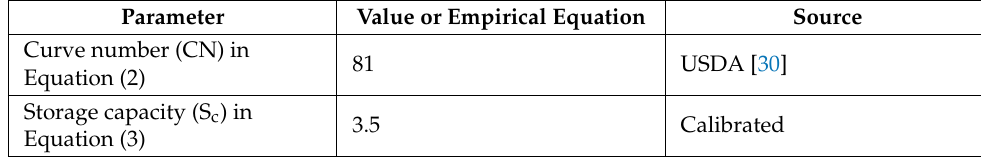
Table 1. Major input parameter values used in this